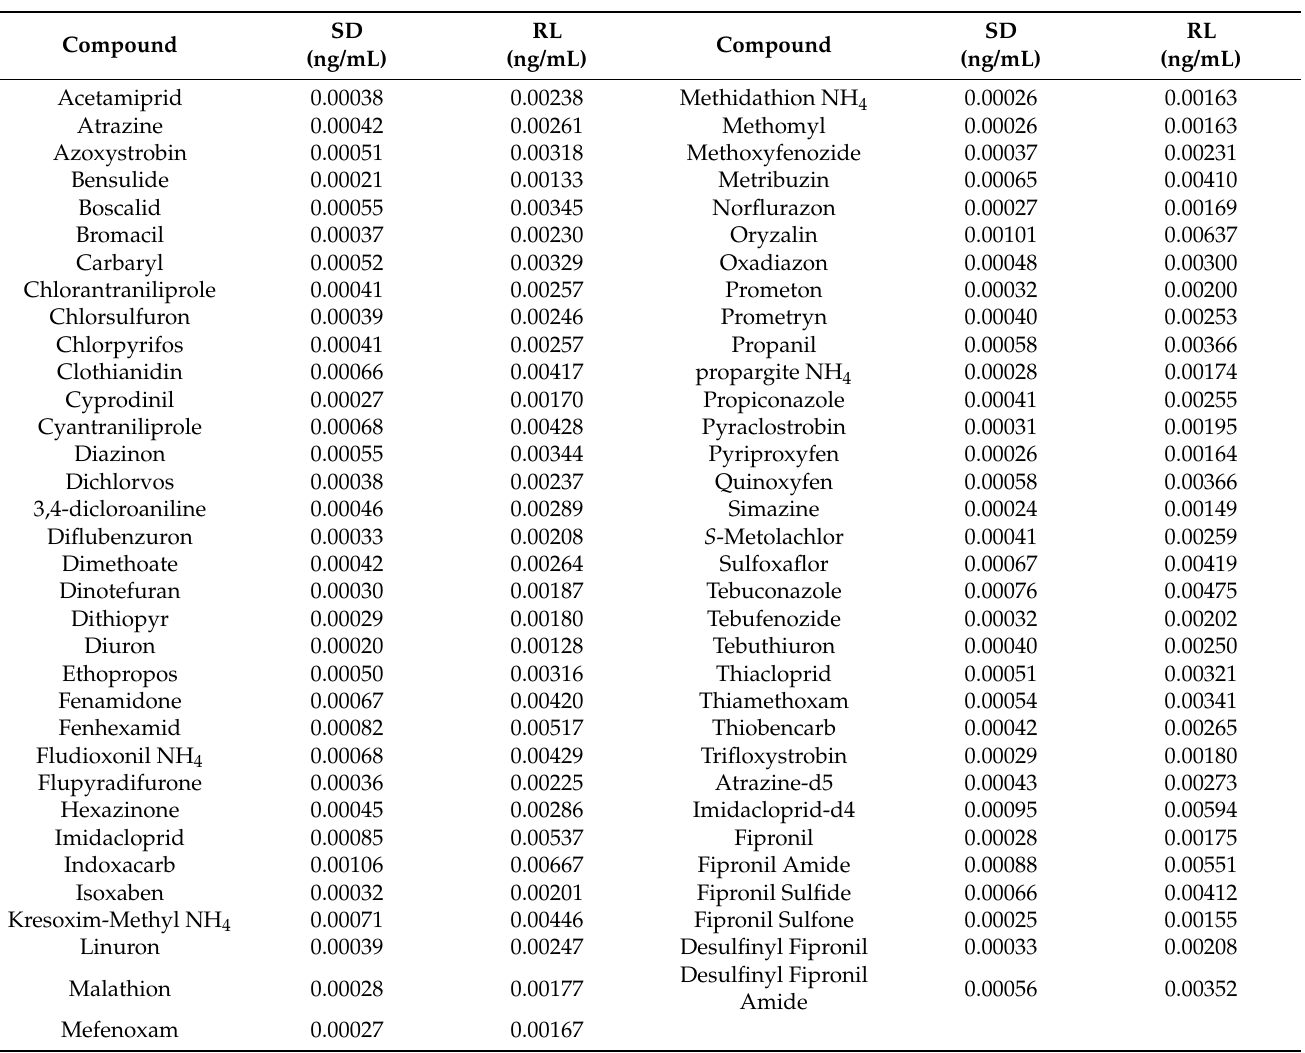
Table 3. RL study for 65 multiresidue pesticides and 2 isotopically labeled standards in water (n = 7) at 0.01 ng/mL.